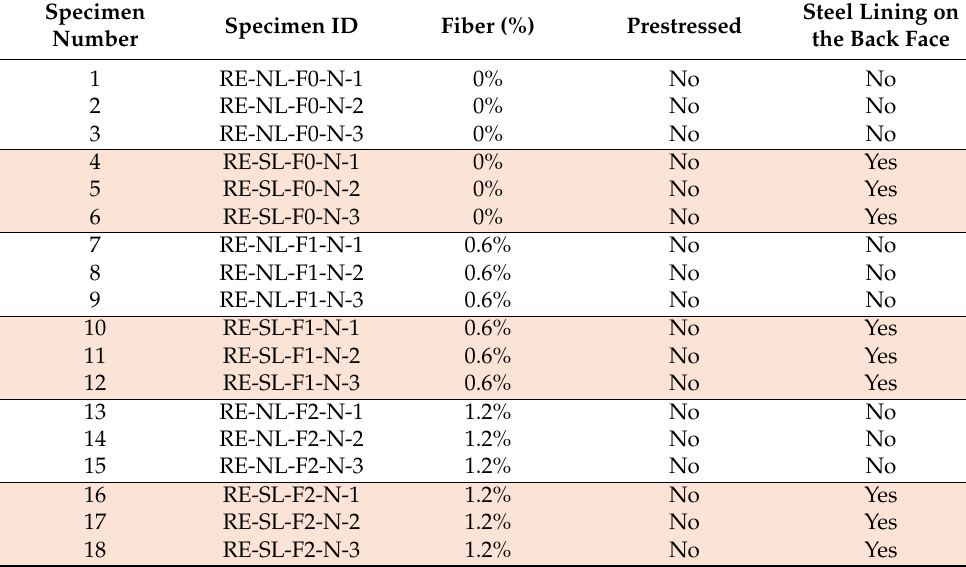
Table 1. Details of the test specimens employed for reliability